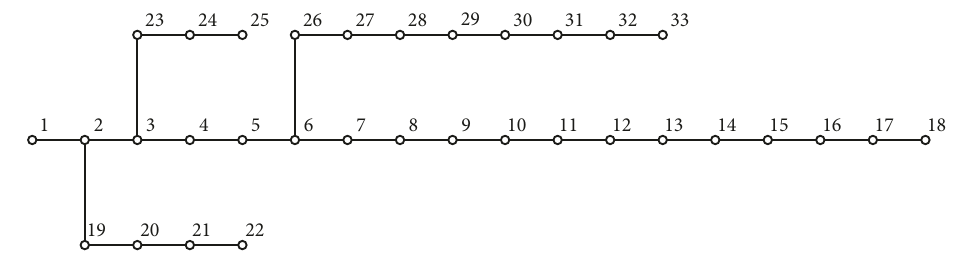
Figure 15: Model for the network